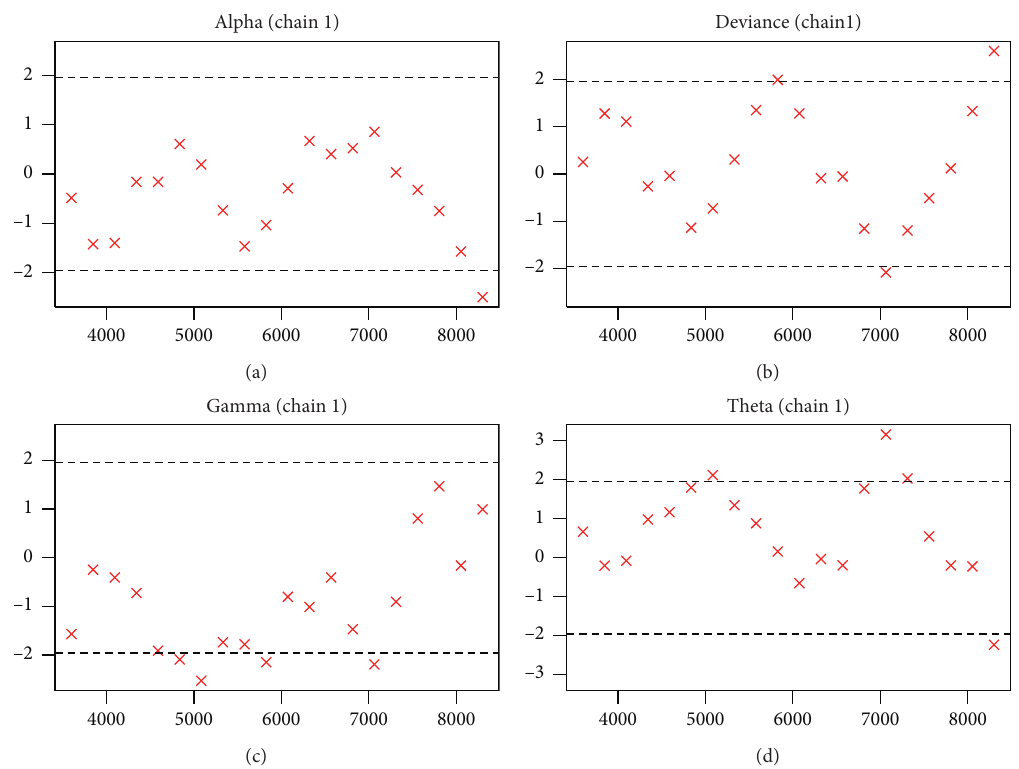
Figure 17: Geweke plot diagnostic (chain 1) for each parameter of NGE-Weibull distribution based on the failure time